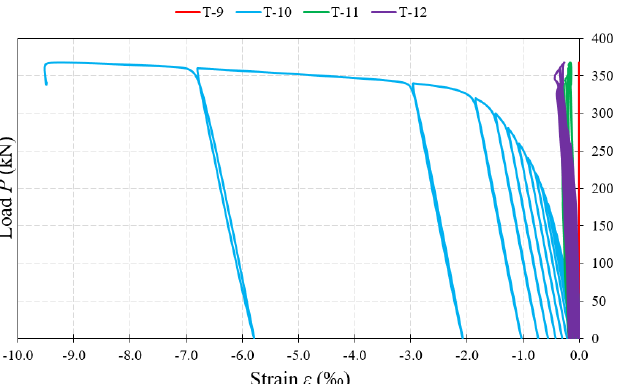
Figure 18. Load–strain relationship in the measurement points (T-5, T-6, T-7, T-8) located on the web surface in the middle part.